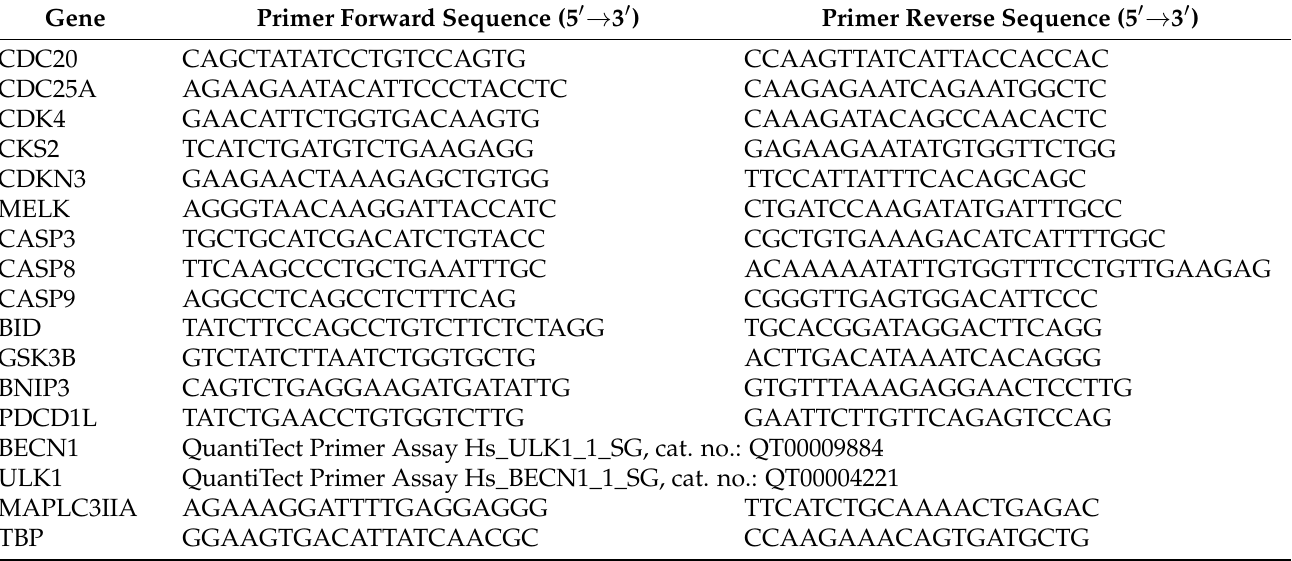
Table 1. Sequences of the primers that were used for the RT-qPCR.